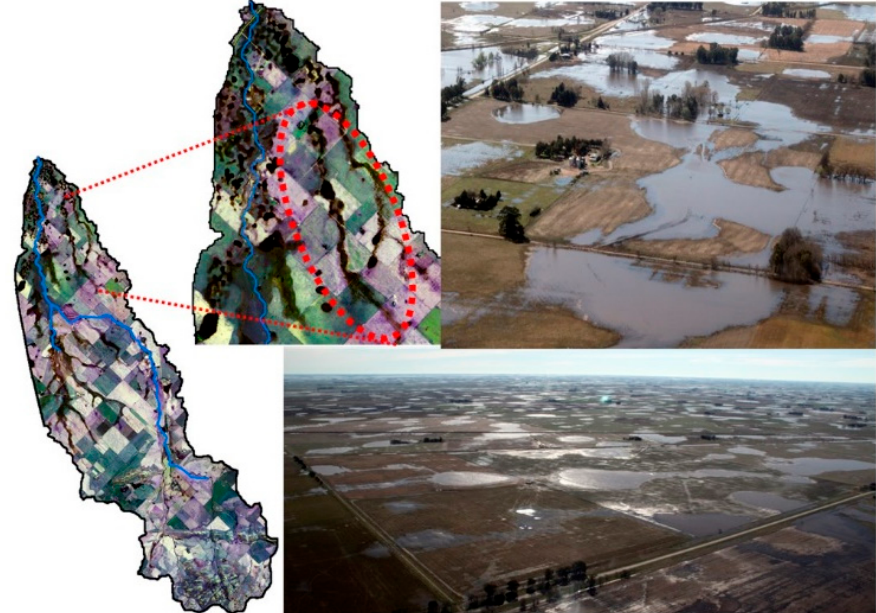
Figure 2. Left: Satellite Pour l’Observation de la Terre (SPOT) satellite image of the Santa Catalina stream basin (and magnification of the lower part of the basin) during a period of water excess (9/13/2012). The Santa Catalina stream watercourse is shown in blue. The encircled area shows the connected deflation hollows running parallel to the stream course. Right: Aerial photographs showing the connection among the water-impounded deflation hollows.